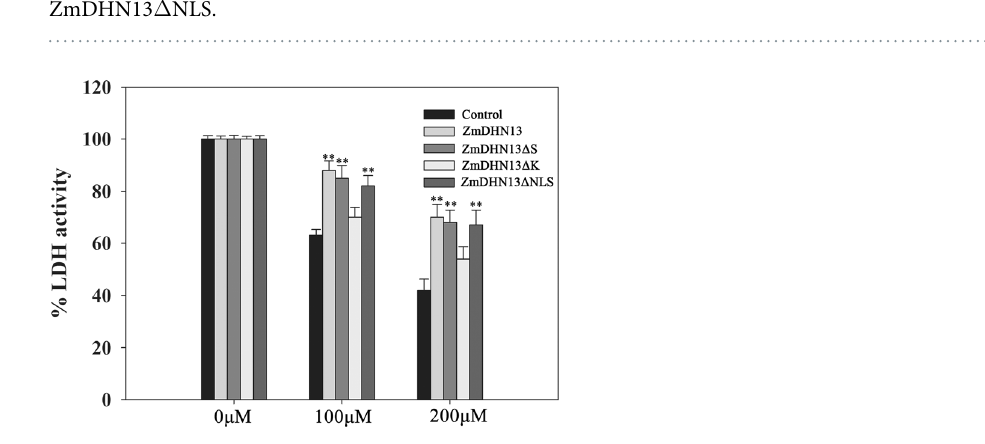
Figure 6. Phosphorylation analysis of ZmDHN13 and its deleted proteins. The recombinant proteins were phosphorylated by CKII. Lanes 1, 2, 3 and 4 indicate the phosphorylated proteins ZmDHN13, ZmDHN13 Δ S, ZmDHN13 Δ K and ZmDHN13 Δ NLS, respectively. Lanes 5 indicates the non-phosphorylated protein ZmDHN13 Δ NLS.